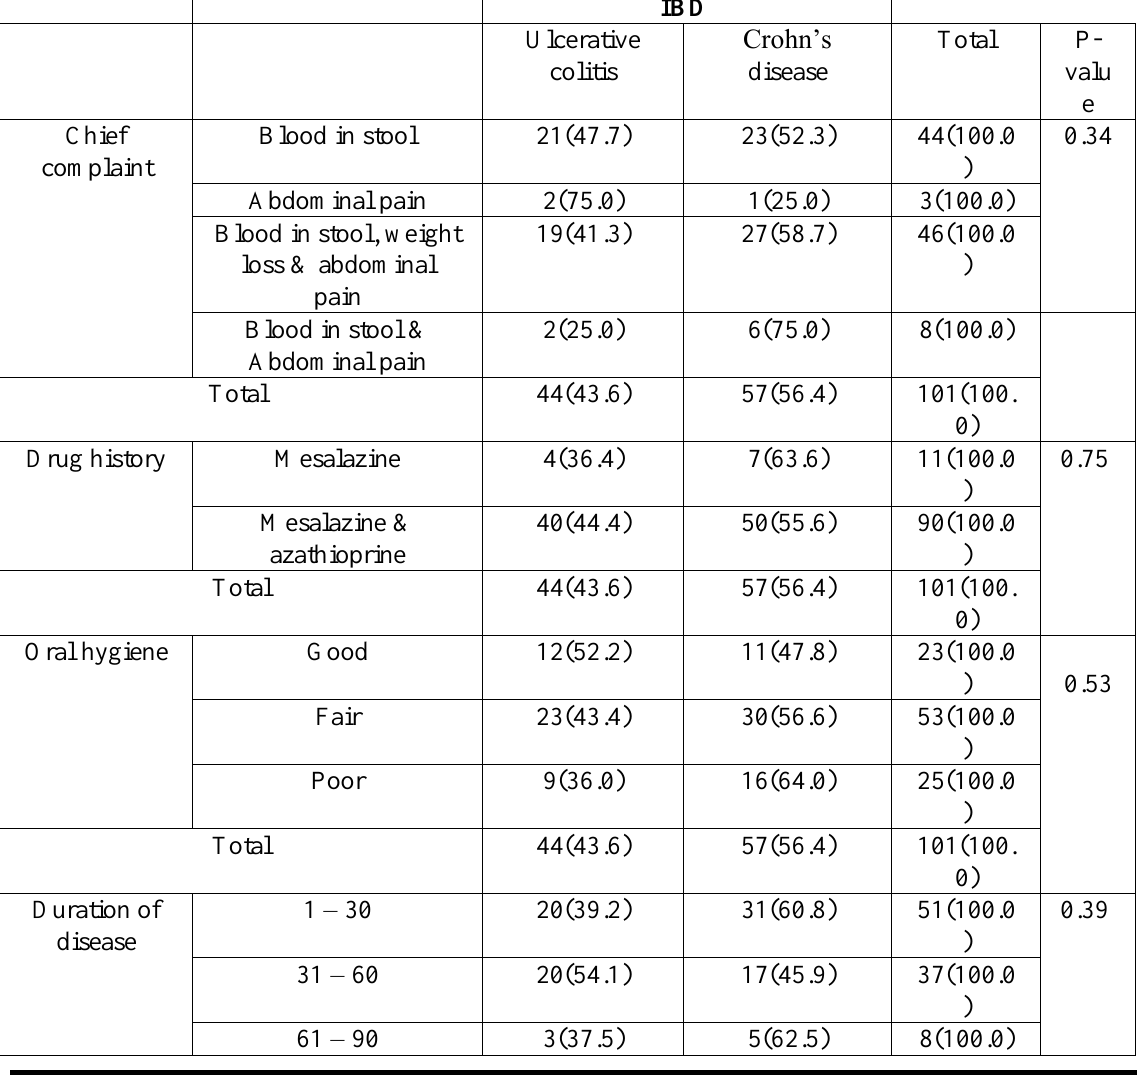
Table (2) The association between clinical characteristics and